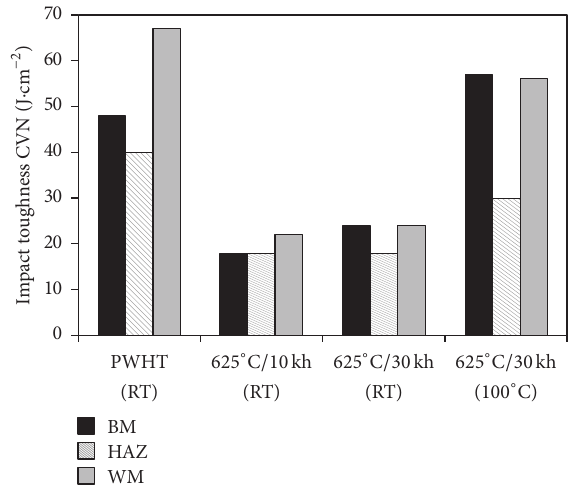
Figure 8: Variation of impact toughness values in dependence of CB2 weld region, its material state and testing temperature. CVN values according to